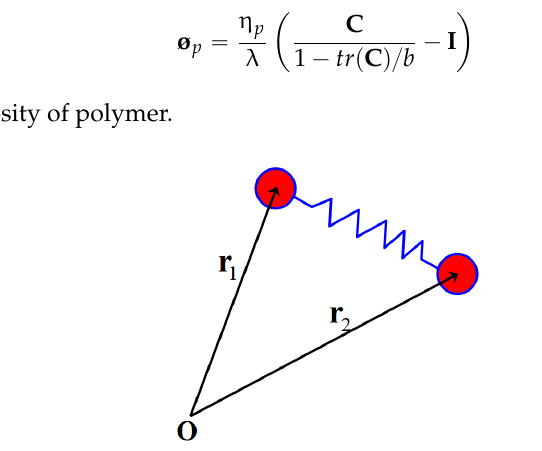
Figure 1. Schematic diagram of the elastic dumbbell. The dumbbell consists of two rigid balls with mass m and position vectors r 1 and r 2 , where the balls are connected by a massless spring and O is the coordinate origin.